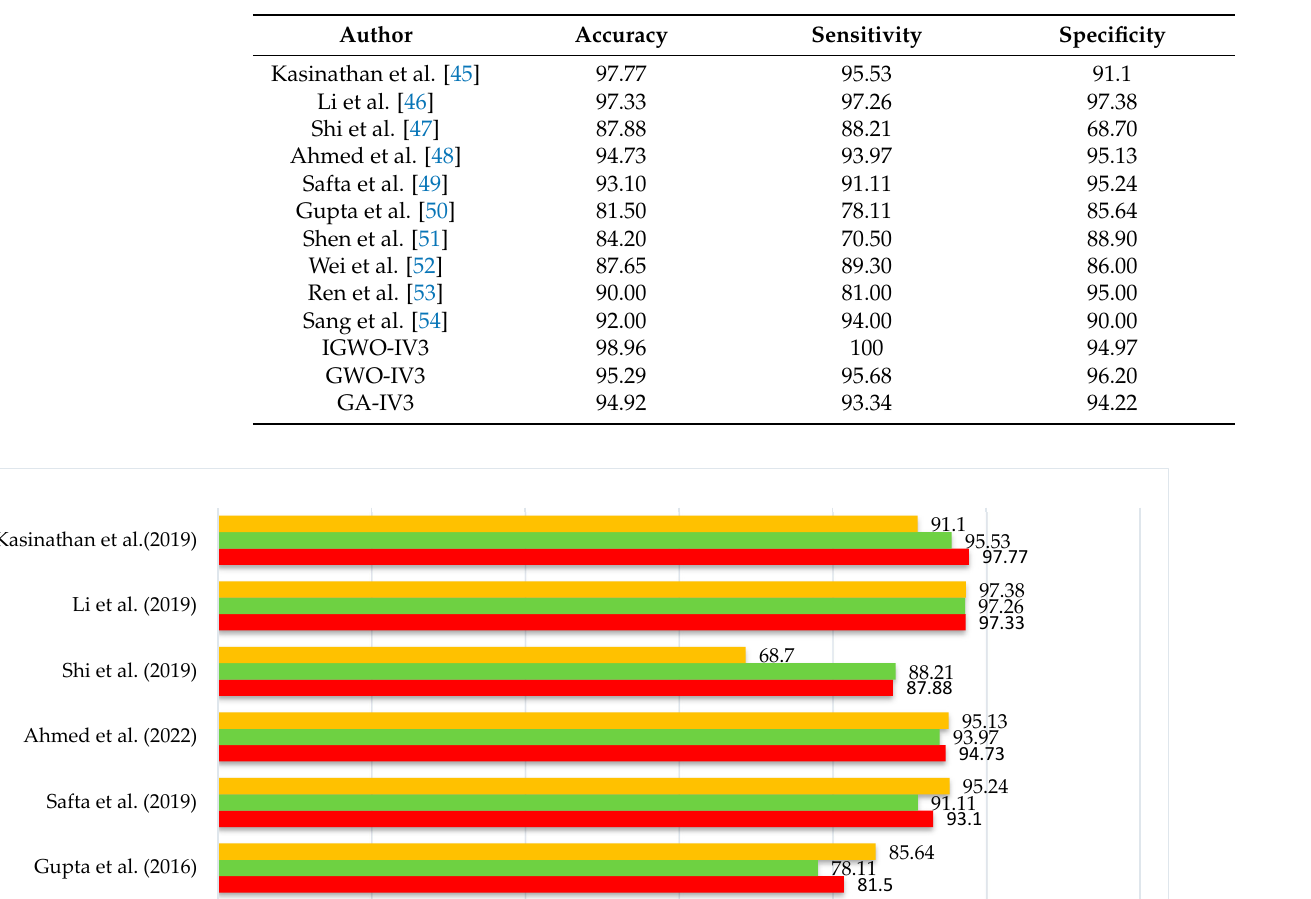
Table 8. A comparison between the proposed work and state-of-the-art models.